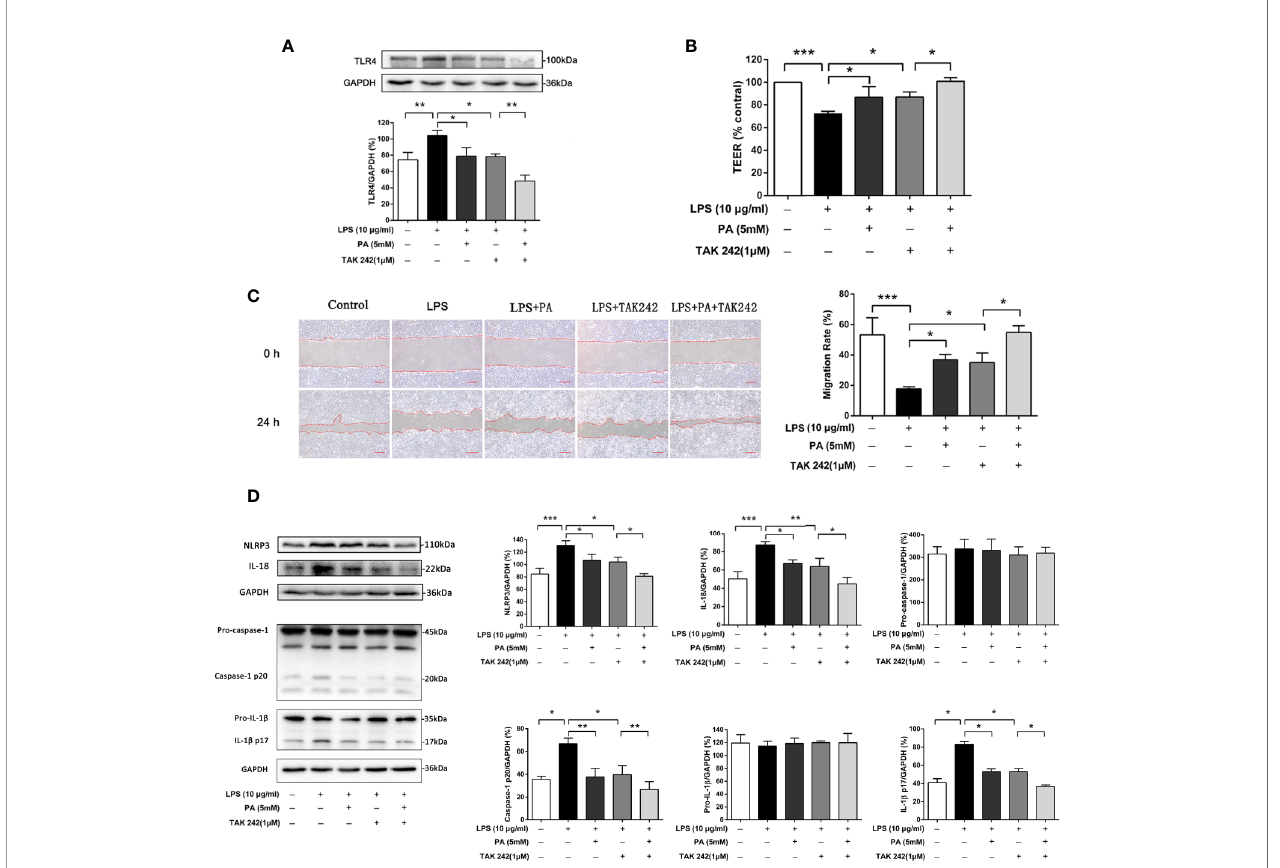
FIGURE 6 | The effects of TLR4/NF- k B pathway on intestinal barrier function, cell migration and NLRP3 in fl ammasome in IEC-6 cells. (A) The protein expression of TLR4 was determined by western blot analysis. (B) The value of TEER. (C) Images of cellular wounds generated were photographed at 0 and 24 h (scale bar: 0.3 mm). Wound healing of IEC-6 cells was assessed by comparing the wound area at 24 h after treatment with that prior to treatment. (D) The expressions of NLRP3, pro-caspase-1, caspase-1, pro-IL-1 b , IL-1 b , and IL-18 at protein levels were determined by western blot analysis. The data represent the averages ± S.D. Signi fi cant differences between the treatment and control groups are indicated as *P < 0.05, **P < 0.01, ***P < 0.001. Signi fi cance was determined by one- way